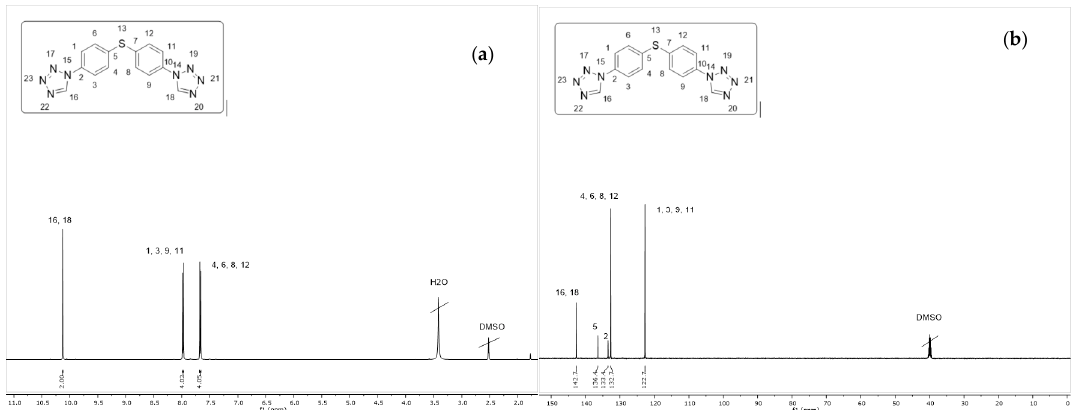
Figure 4. ( a ) 1 H NMR spectrum of the thioether-linked bis -tetrazole 5 . ( b ) 13 C NMR spectrum of 5